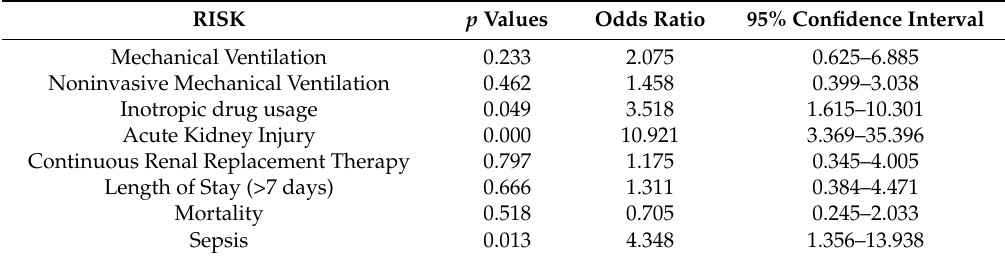
Table 6. Risk factors of patients with UA > 7 mg/dL (binary logistic regression models). RISK p Values Odds